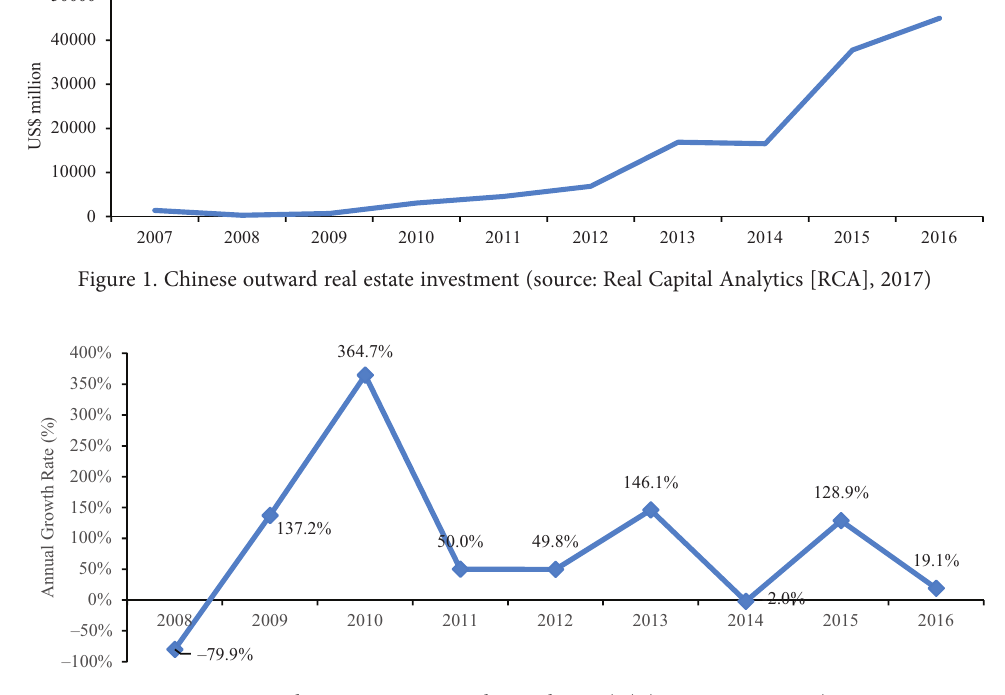
Figure 2. Chinese FDIRE annual growth rate (%) (source: RCA,